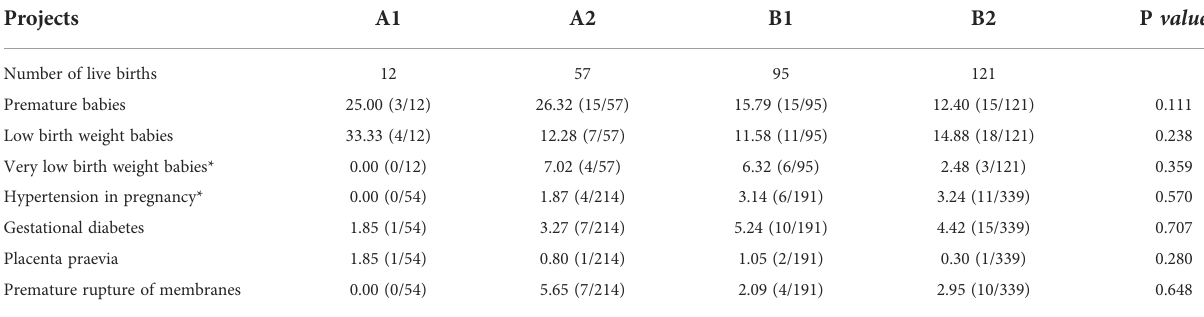
TABLE 7 Analysis of perinatal